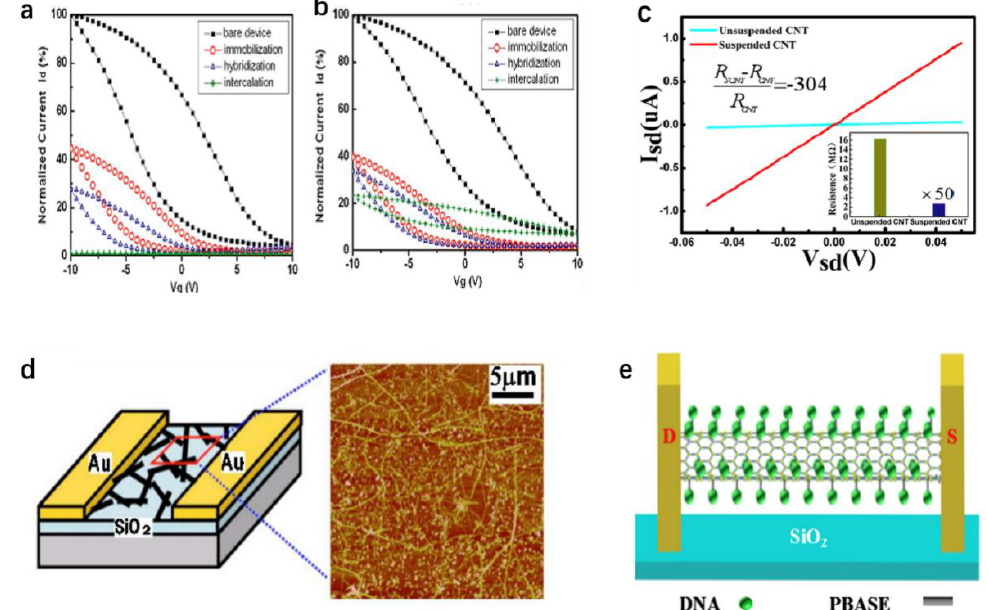
Figure 5. ( a ) Hybridized with a complementary target analyte; ( b ) Typical gate voltage dependence of a normalized drain current DS hybridized with a single-base mismatch target analyte; ( c ) Com- parison of the electrical conductivity between the suspended CNT and the unsuspended CNT. In the illustration, × 50 represents the 50-fold amplification of the resistance of the suspended CNT. Reproduced from sun et al. [115] by permission of Elsevier Science Ltd.; ( d ) Device schematics and atomic force microscope images. Reproduced from Gui et al. [124] by permission of the American Institute of Physics; ( e ) Schemata of a SCNT-FET.